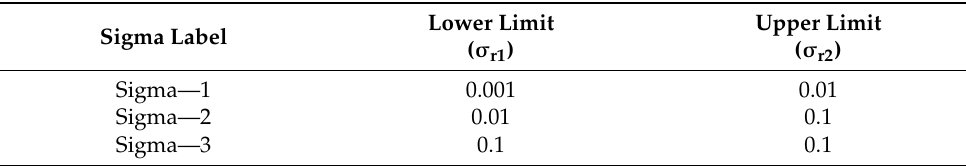
Table 1. Limits of the standard deviation values chosen for particle